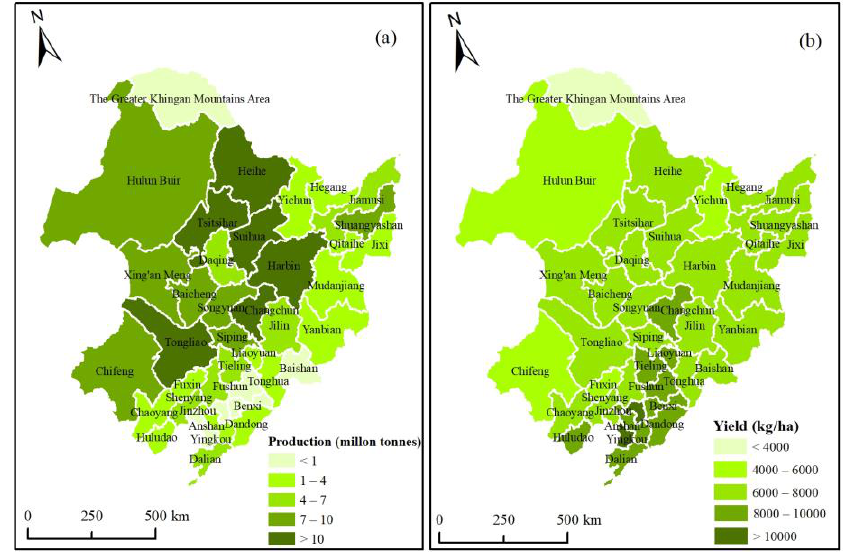
Figure 7. Maize potential production ( a ) and yields ( b ) in prefecture-level cities in